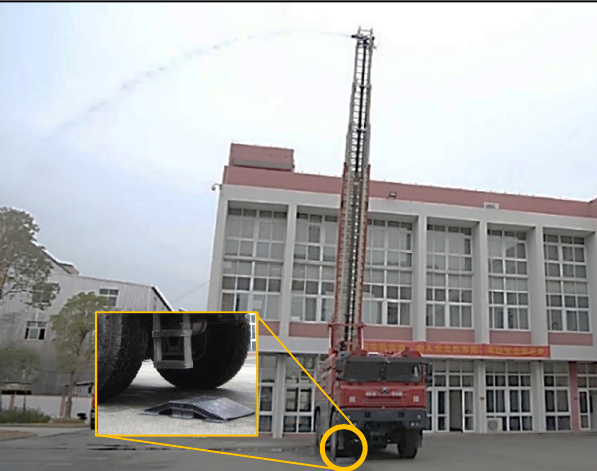
Figure 12. Triangle obstacle. During the experiment, triangular obstacles were placed on one or two sides in front of the vehicle. The control program was started, the vehicle was moved over the triangular obstacles, and changes in body pitch and roll angle were recorded. The control procedure was switched off, the suspension system was switched to hydro-pneumatic passive suspension, the vehicle was moved over the triangular obstacles at the same speed and manner, and the pitch and roll angle of the vehicle were recorded. Figure 13 shows the pitch and roll angle curves of the vehicle with the wheels on one side crossing a triangular obstacle at a speed of 3.2 km/h. Figure 14 shows the pitch and roll angle curves of the vehicle with the wheels of two sides crossing a triangular obstacle at a speed of 3.2 km/h.